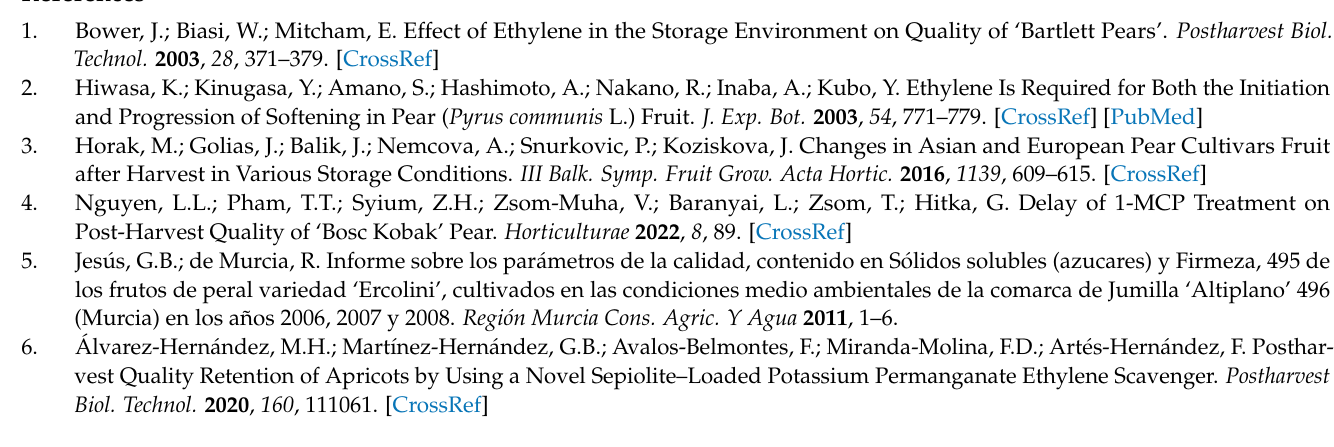
Table S3: Evolution during storage time of the bioactive compounds in pears subjected to different treatments: 1 ◦ C-C (Control), 1 ◦ C-F (Filter), 1 ◦ C-FD (Filter + Device), 8 ◦ C-C (Control), 8 ◦ C-F (Filter) and 8 ◦ C-FD (Filter + Device); Table S4: Principal Component Analysis; Table S5: Table of Component Weights; Table S6a: This table shows the scores of the principal components; Table S6b: ANOVA table for the component 1 scores according to the treatments; Table S6c: Multiple comparisons test for the component 1 scores by treatments using Tukey HSD method; Table S6d: ANOVA table for the component 2 scores according to the treatments; Table S6e: Multiple comparisons test for the component 2 scores by treatments using Tukey’s HSD